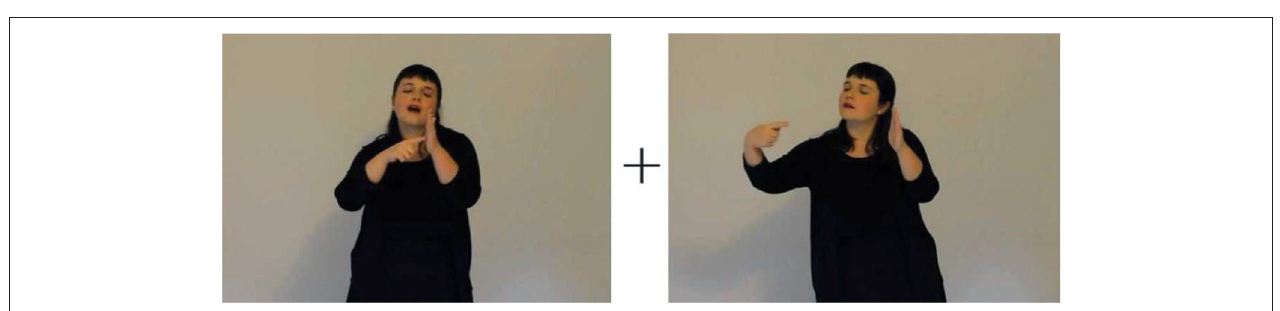
FIGURE 4 | Our translation of “e il suon di lei” (“and how it